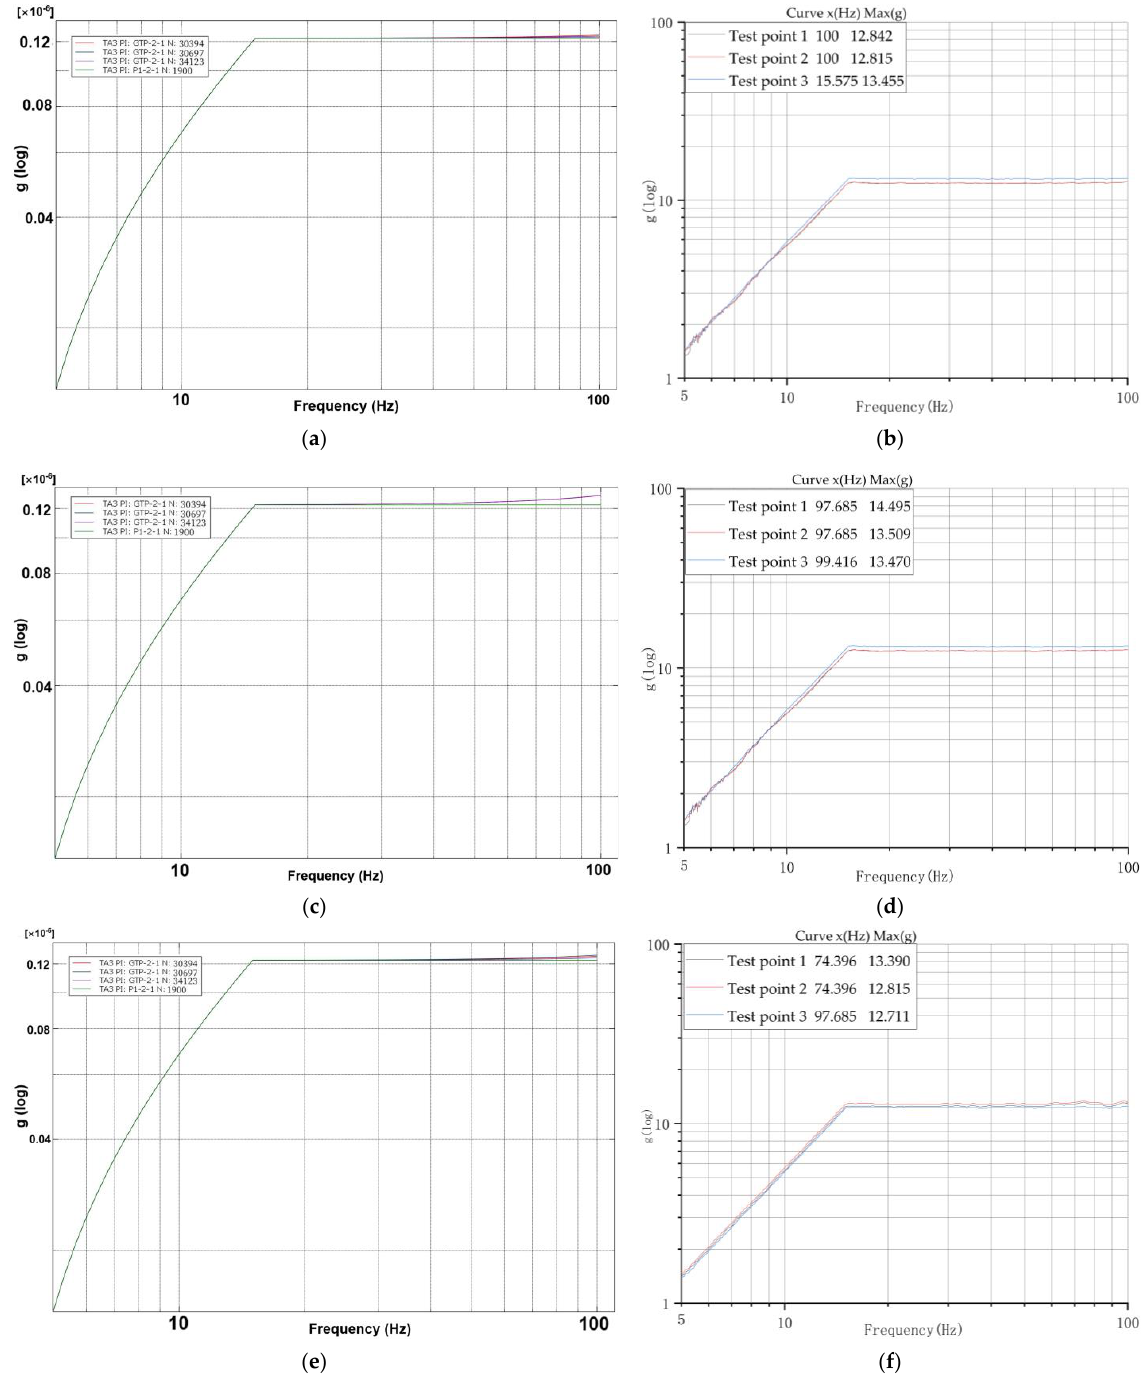
Figure 11. Comparison of acceleration response curve between theoretical analysis and experimental test: ( a ) Acceleration response curve of theoretical analysis in X-directional. ( b ) Acceleration response curve of experimental test in X-directional. ( c ) Acceleration response curve of theoretical analysis in Y-direction. ( d ) Acceleration response curve of experimental test in Y-direction. ( e ) Acceleration response curve of theoretical analysis in Z-directional. ( f ) Acceleration response curve of experimental test in Z-directional.